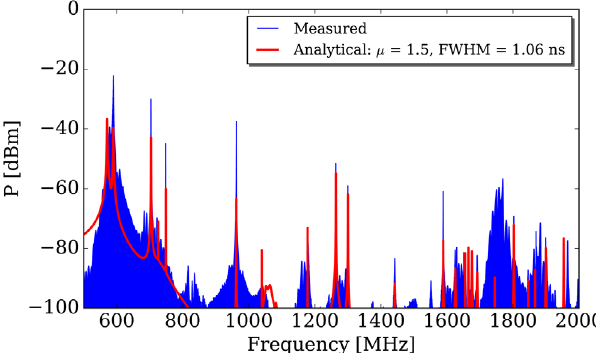
6. Measured HOM power vs frequency, comparing measured data (blue) and simulated values (red).